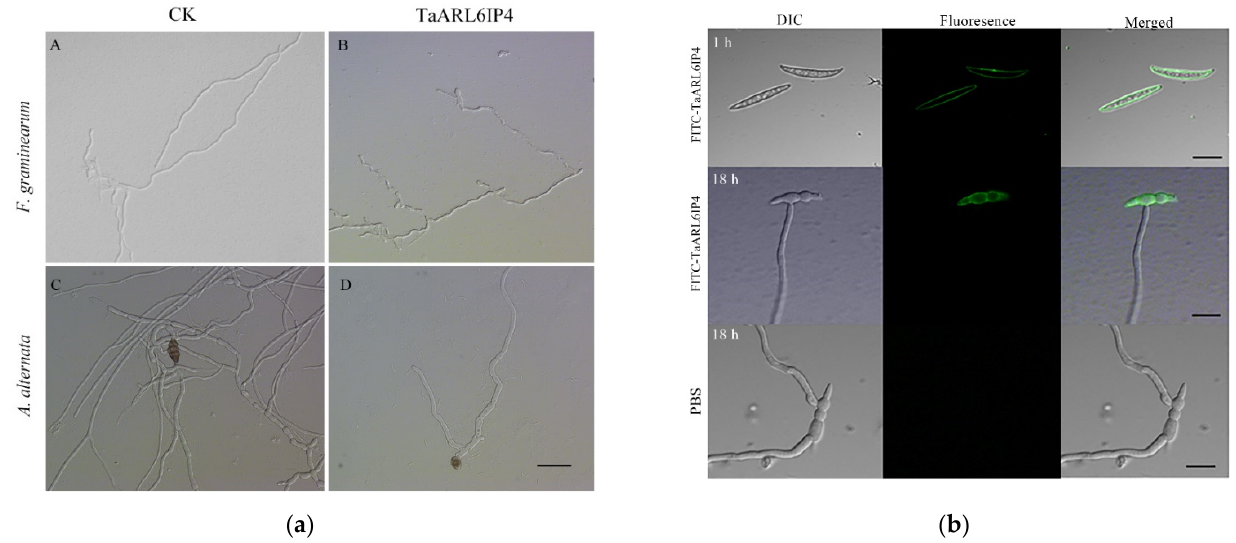
Table 1. Antifungal analysis of TaARL6IP4 against representative fungi.